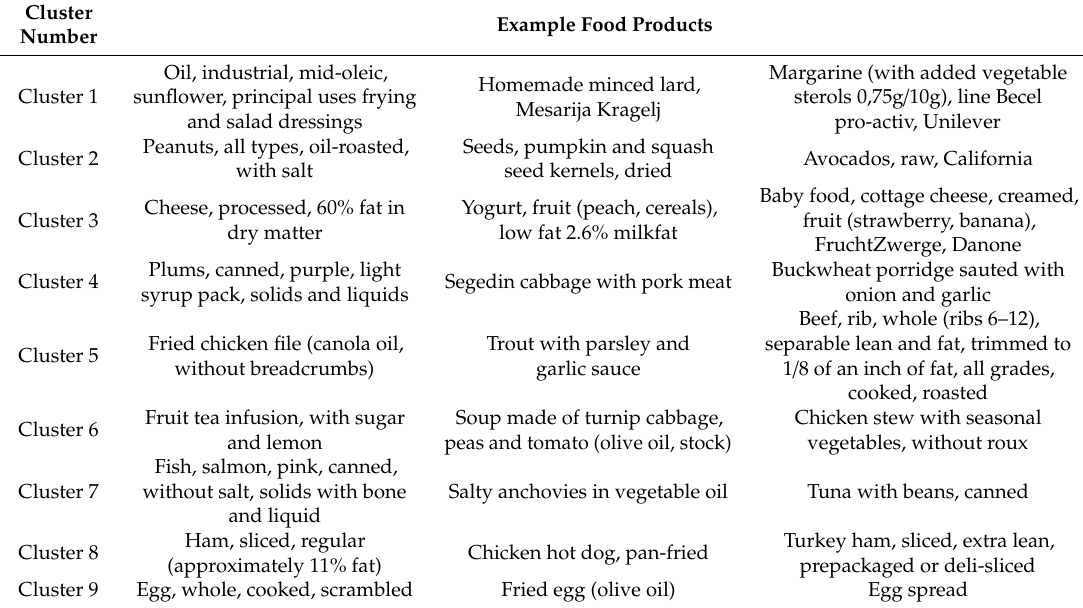
Table 4. Example instances from each